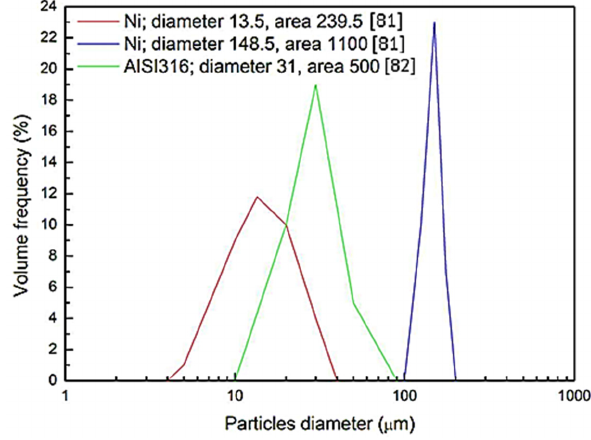
Figure 7. Particles size and distribution of selected examples [81,82].